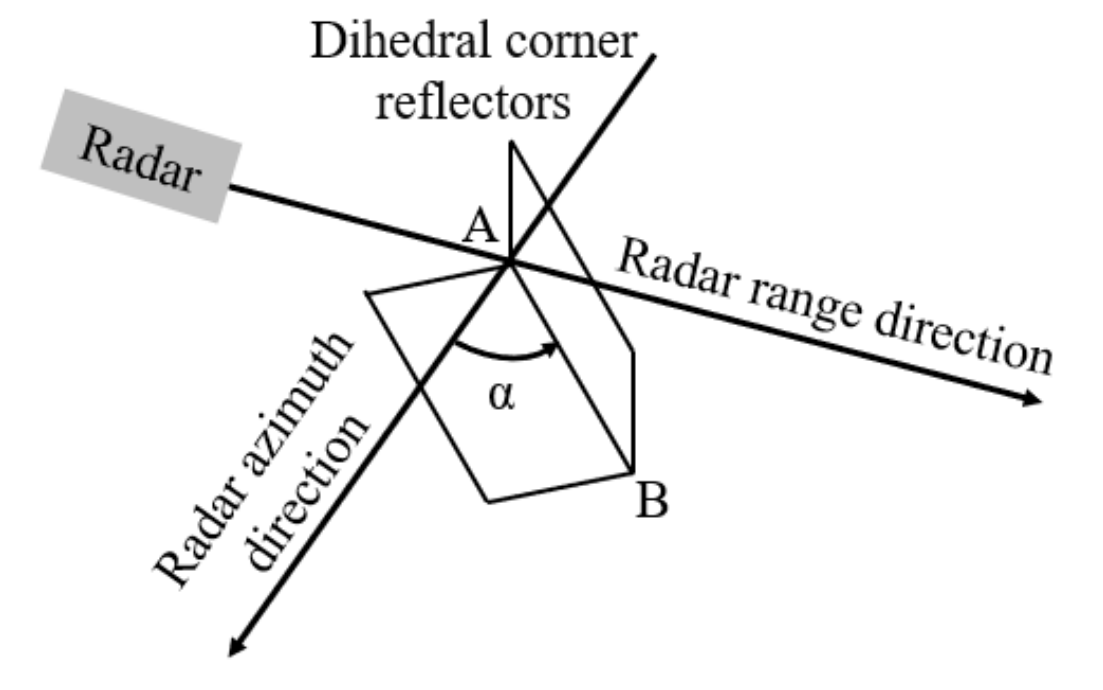
Figure 2. Dihedral reflector and radar scattering geometry scheme.